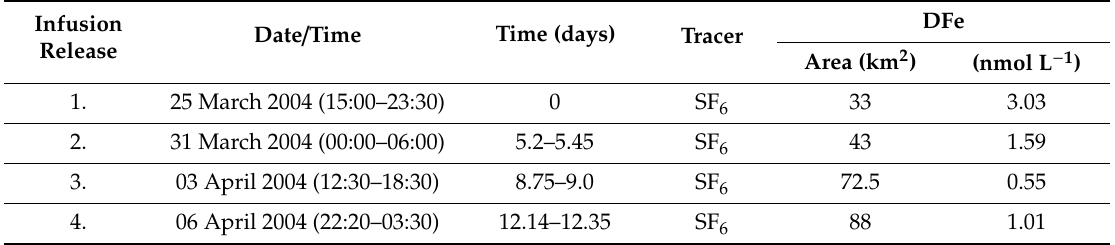
Table 1. Information on iron infusions during the SAGE experiment *.